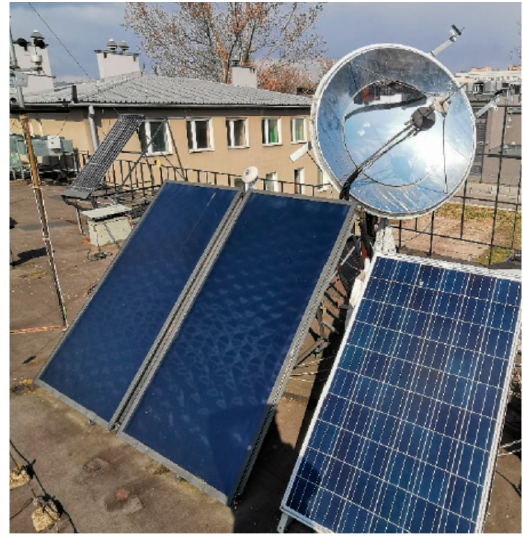
Figure 3. Parabolic dish concentrator [17] .